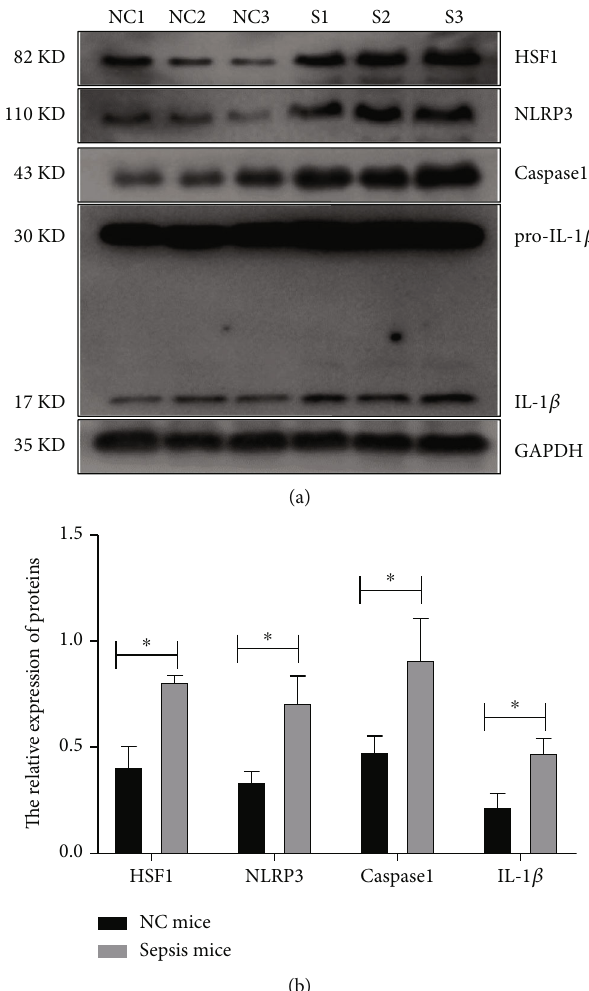
Figure 1: Expression of HSF1, cytokines, and pyrolytic proteins in the hippocampus. (a) Western blot analysis was performed to detect the expression of the in fl ammatory cytokines and pyrolytic proteins in hippocampal tissue. NC1-NC3: negative control group (sham group); S1-S3: sepsis group. (b) WB images were quanti fi ed, and their statistical analysis is shown in the graph. Experiments were repeated independently, ∗ p < 0 : 05